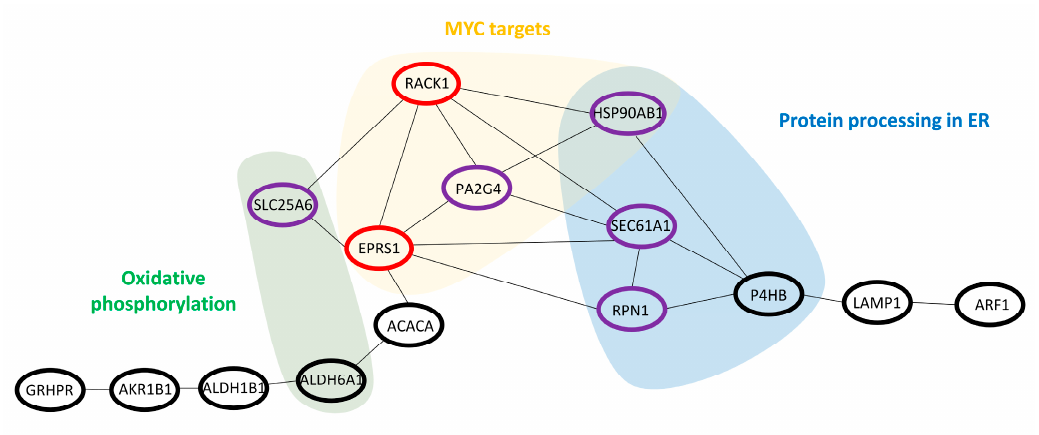
Figure 3. Protein–protein interaction network and associated pathways / hallmarks: Interaction network of proteins associated with progression at protein and mRNA levels. Nodes (proteins) connecting all three pathways / hallmarks are highlighted in red, while those nodes connecting between two pathways / hallmarks are marked in purple. Disconnected nodes in the network are not shown. Colour clouds represent proteins belonging to the indicated pathway/hallmark.